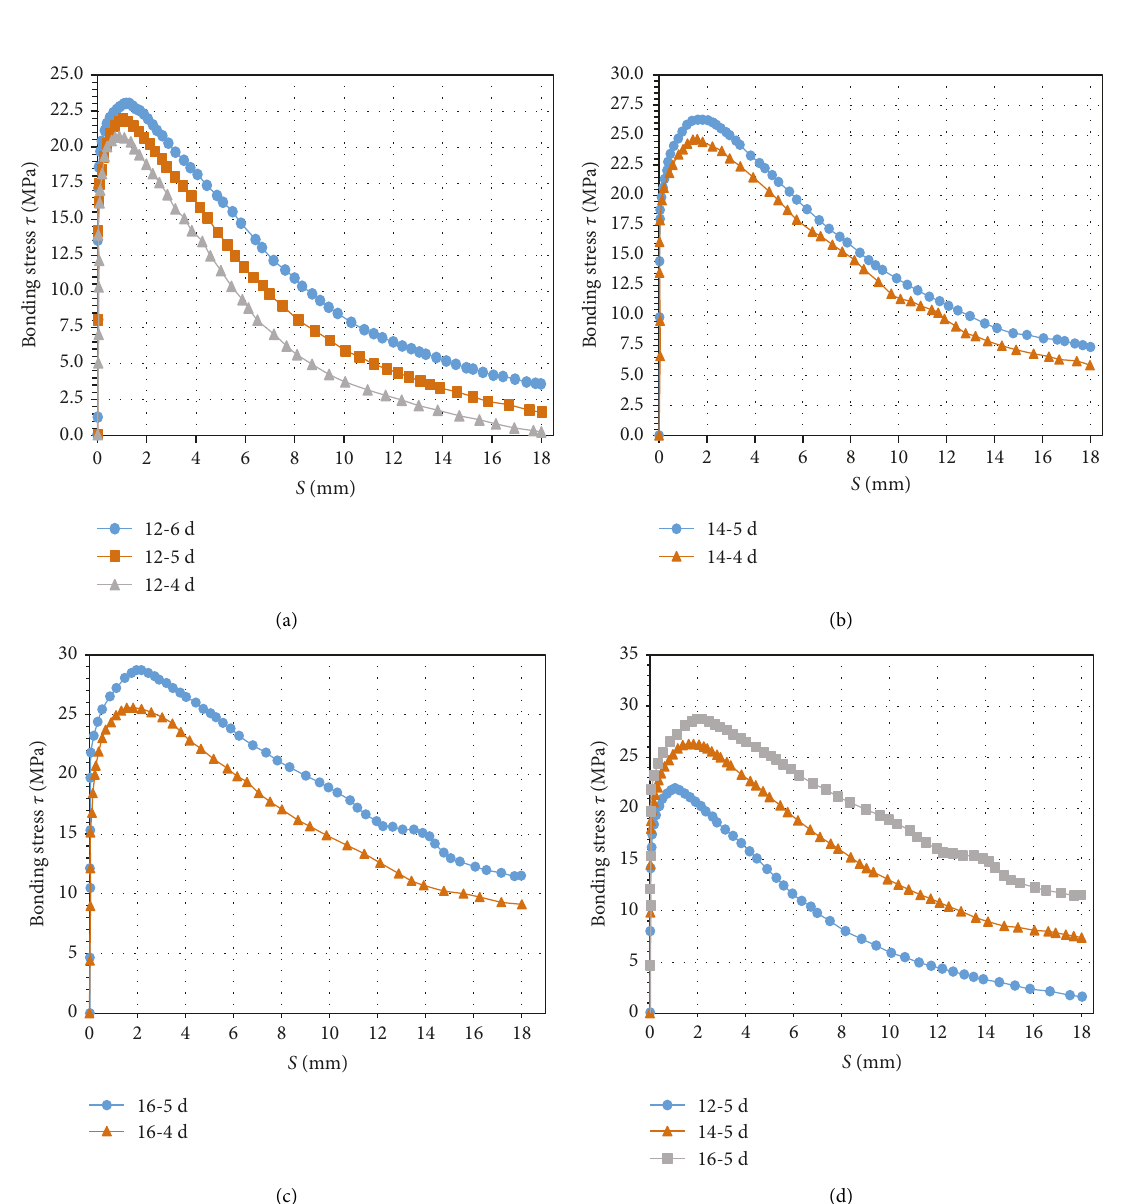
Figure 33: Bond stress-slip curves of polyurethane concrete reinforcement pull-out